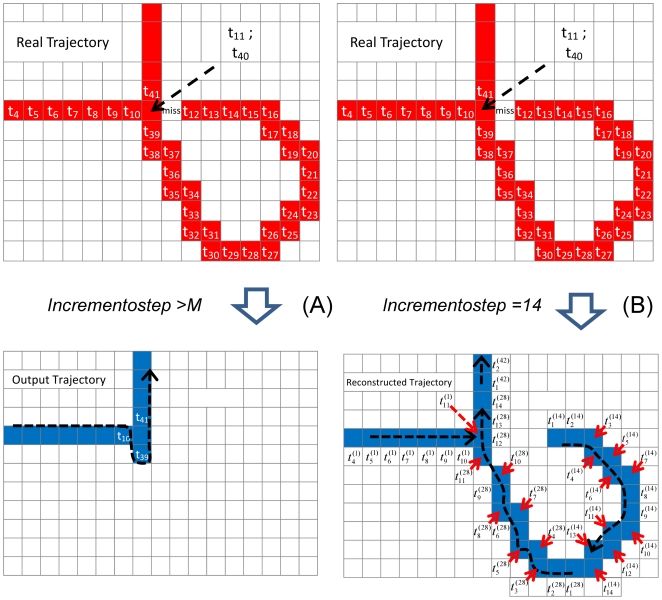
Sketch of the occupancy time for the case of a loop in a single trajectory.One of the positions close to the loop has not been segmented and is missing (indicated as “miss” in the top left panel). In panel A we sketch the situation encountered by the basic tracking algorithm (incrementostep is larger than the total number of frames in the stack, M). In such a case the algorithm takes a detour and skip the loop (bottom panel A). In panel B we report the case incrementostep = 14<M. The tracking algorithm perform a search also starting from the frames 14, 28, … In this case a large fraction of the loop is rebuilt in two distinct sub-trajectories (bottom B panel).